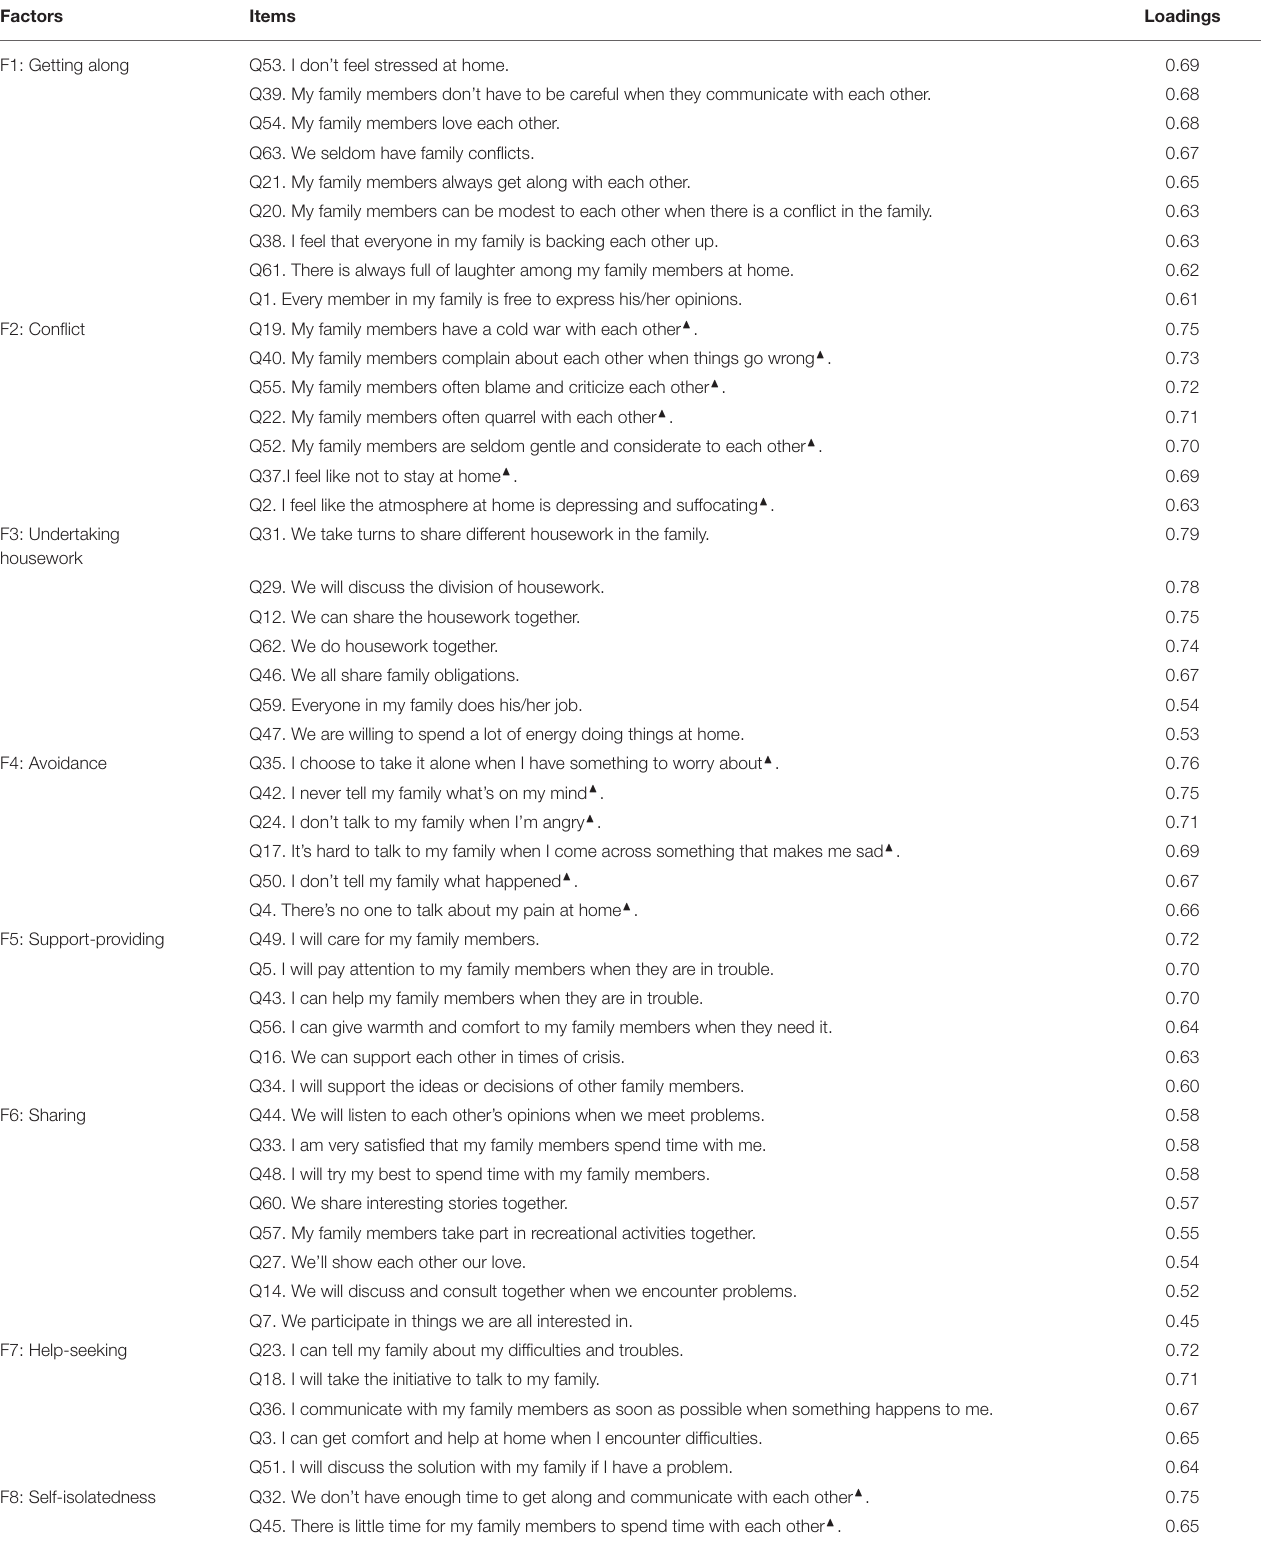
TABLE 2 | Nine factors of the CSEFHQ and their factor loadings ( N = 562). Factors Items